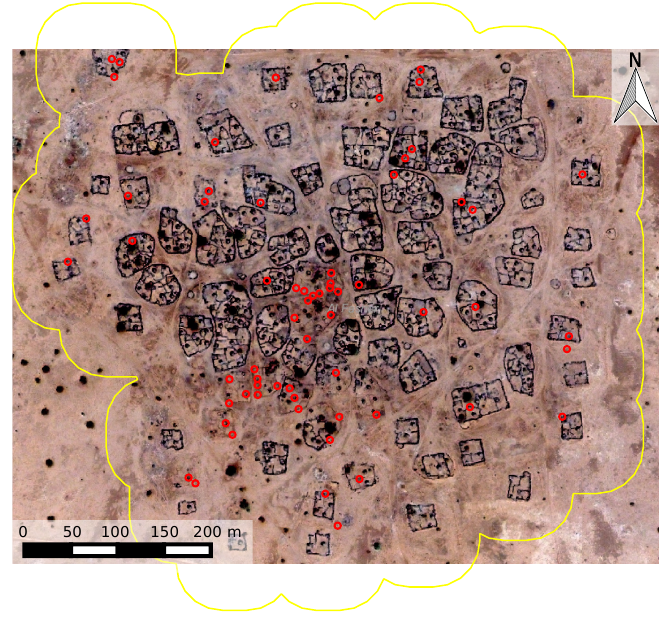
Figure 4. Post-conflict image (location: 13.686 ◦ N, 24.979 ◦ E) with two results of the example analysis. The detected settlement area is the yellow polygon. The results of the damage assessment, i.e., the disappeared dwellings, are the red circles (image c (cid:13) 2016